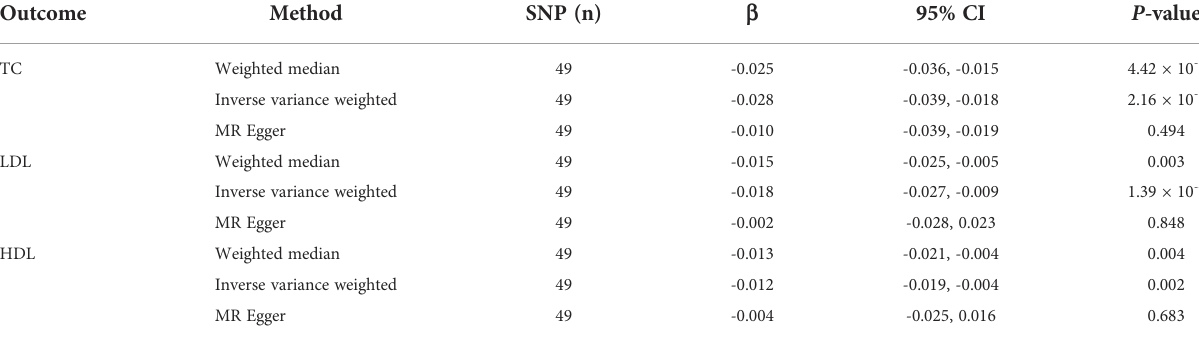
TABLE 2 The Mendelian randomization (MR) analysis results with regard to causal effect of SLE on TC, LDL, and HDL levels.